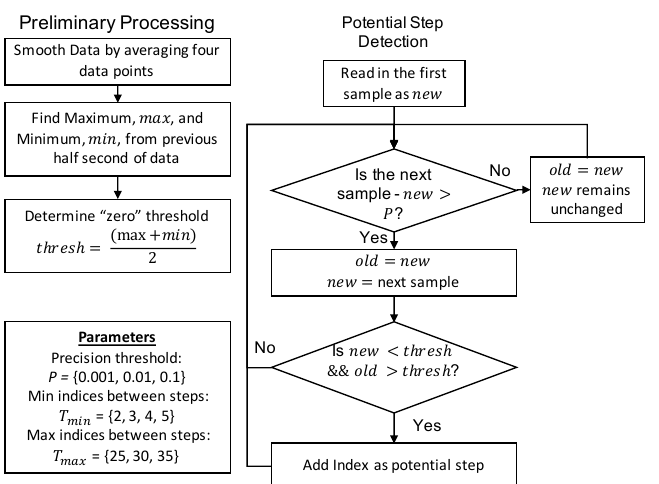
Figure 6. Flow chart describing the process for identifying potential steps in the threshold based algorithm.